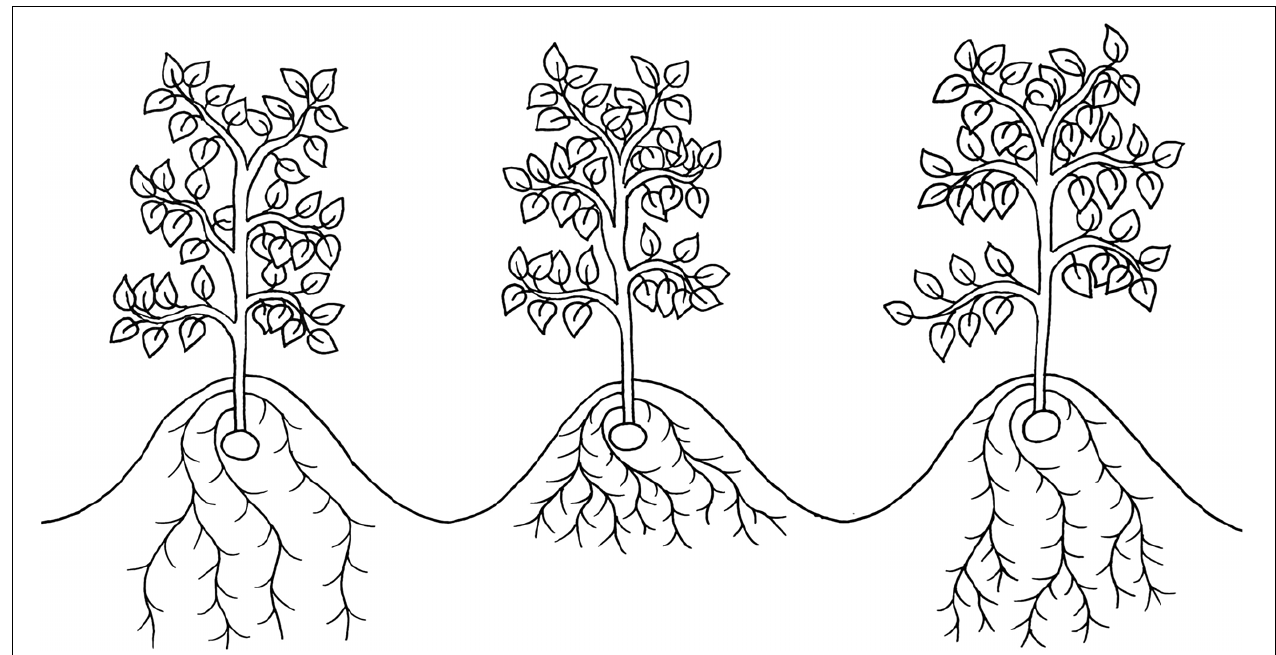
FIGURE 1 | An illustration of three root morphotypes which have been suggested to improve drought tolerance in potato: deep roots (left), dense roots in shallow soil strata (middle) and dense roots in deep soil strata (right).